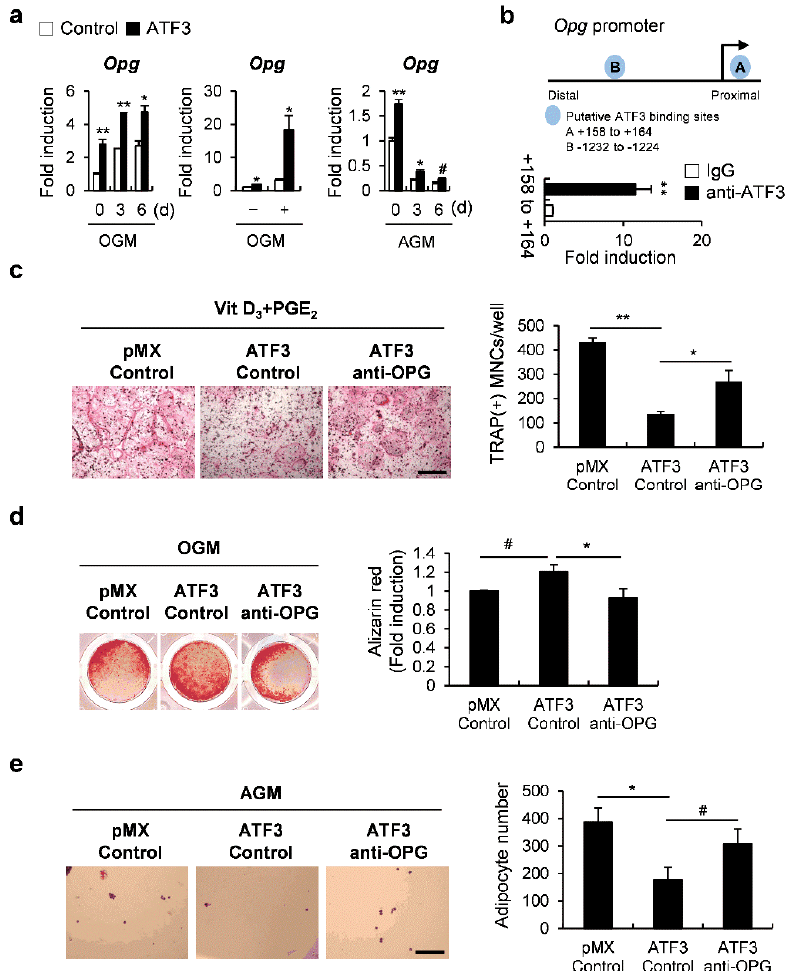
Figure 6. ATF3 simultaneously regulates the differentiation of osteoclasts, osteoblasts, and adipocytes via induction of OPG expression. ( a ) Primary osteoblast precursors transduced with pMX-IRES-EGFP (control) or ATF3 were cultured in OGM (left panel) or AGM (right panel). Cells were cultured for the indicated time points and the expression levels of the indicated genes were analyzed by real-time PCR. ( b ) Illustration of ATF3 candidate binding motifs in an Opg promoter (upper panel); chromatin immunoprecipitation assay of osteoblasts was conducted against an ATF3 antibody (lower panel). ( c ) Primary osteoblast precursors transduced with pMX-IRES-EGFP (control) or ATF3 retrovirus were co-cultured with BMCs in the presence of Vit D 3 and PGE 2 and in the pres- ence or absence of OPG neutralizing antibody (anti-OPG). The cultured cells were stained for TRAP (left panel). TRAP-positive multinucleated cells were quantified (right panel), scale bar: 200 µm. ( d ) Primary osteoblast precursors were cultured in OGM for 3 days. Immature osteoblasts were trans- duced with pMX-IRES-EGFP (control) or ATF3 retrovirus and were further cultured in OGM in the presence or absence of anti-OPG. The cultured cells were stained with Alizarin Red (left panel). Alizarin Red staining was quantified by densitometry at 405 nm (right panel). ( e ) Primary osteoblast precursors were transduced with pMX-IRES-EGFP (control) or ATF3 retrovirus in the presence or absence of anti-OPG, and cultured in AGM. The cells cultured in AGM for 6 days were stained with Oil Red O (left panel). Oil Red O-positive lipid droplets containing adipocytes were quantified (right panel), scale bar: 200 µm. # p < 0.05, * p < 0.01, ** p < 0.001 vs. control.